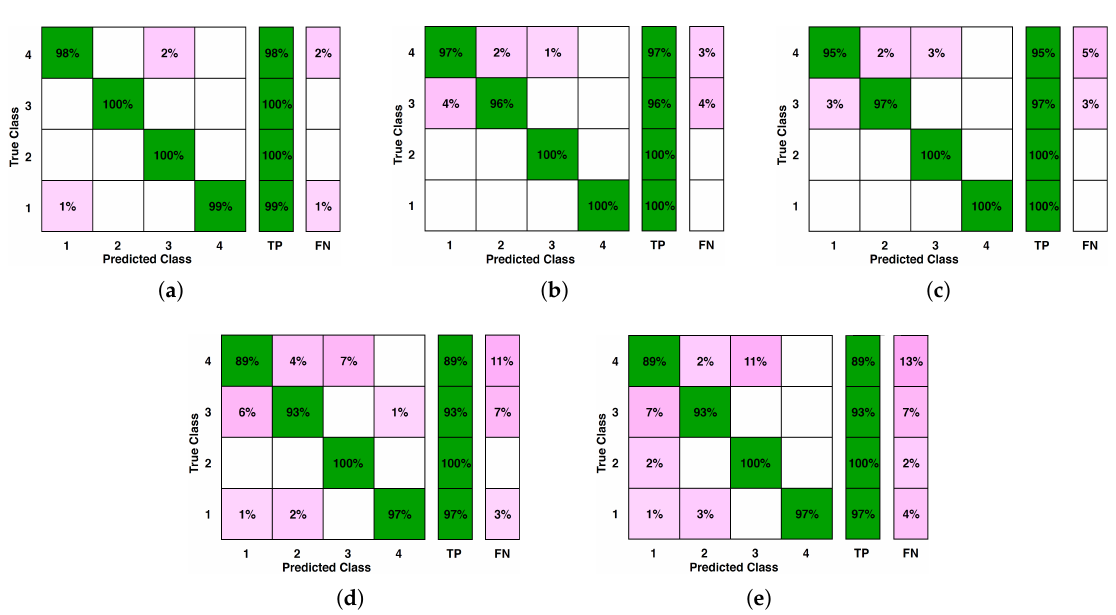
Figure 10. Confusion Matrices of classification results generated by k -NN classifier for : ( a ) original signal, ( b ) CS undersampling by factor of 2, ( c ) CS undersampling by factor of 4, ( d ) CS undersampling by factor of 8 and ( e ) CS undersampling by factor of